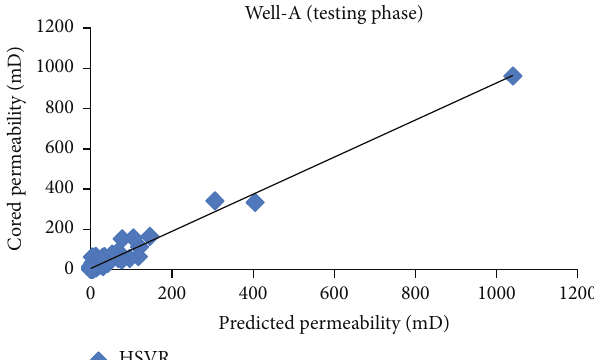
Figure 13: Cross plot of cored and predicted permeability for HSVR model.